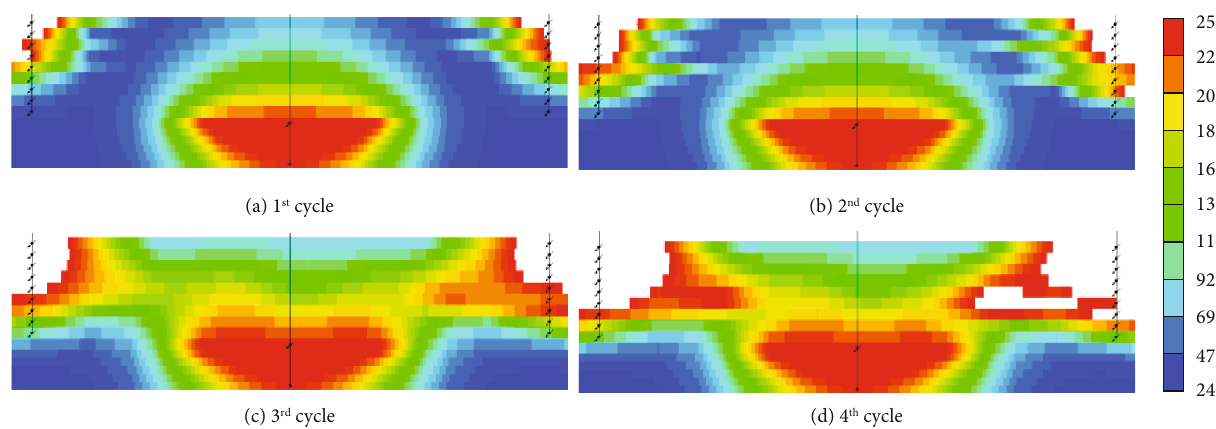
Figure 17: Temperature pro fi les at the end of injection of di ff erent